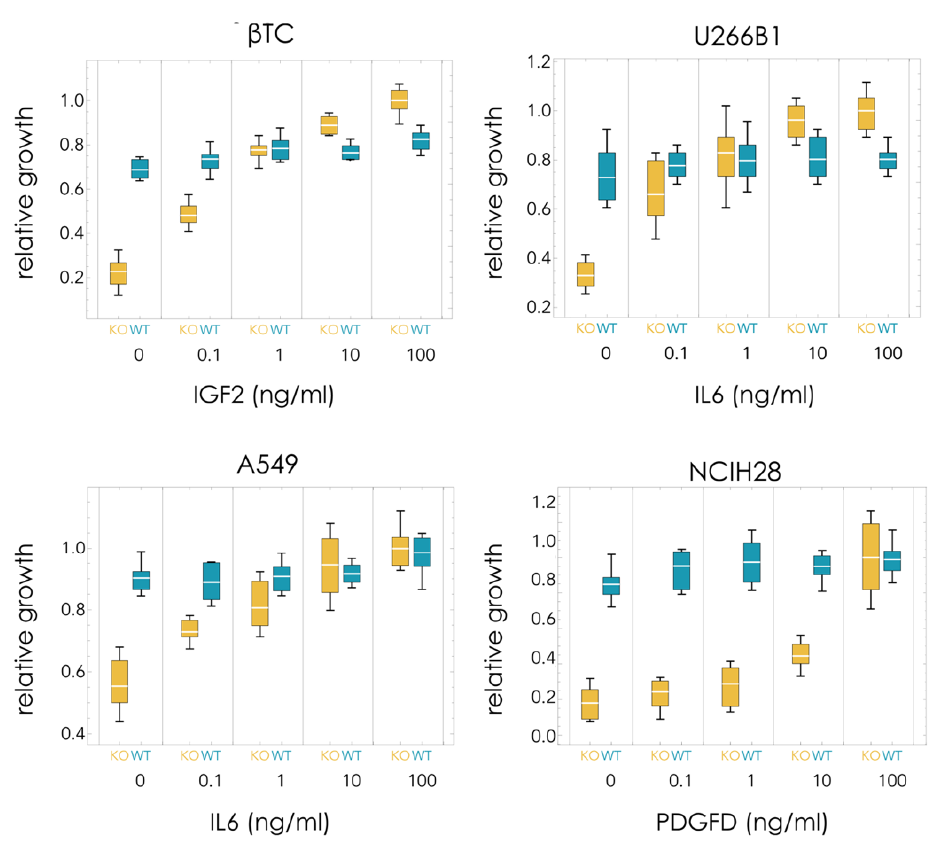
Figure 2. Growth rates of pure WT or KO populations with different amounts of exogenous growth factor (5% FBS).